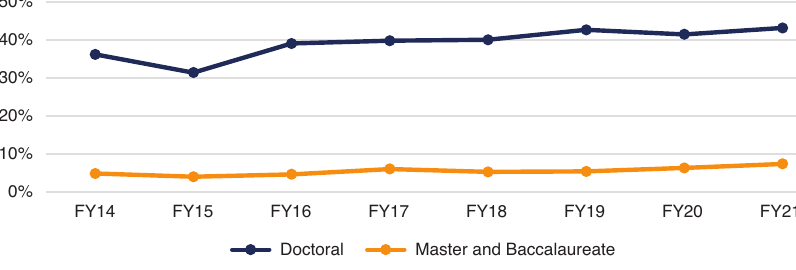
Chart 7: Percentage of U.S. Four-Year and Graduate Institutions Support OA Publishing Through LYRASIS,